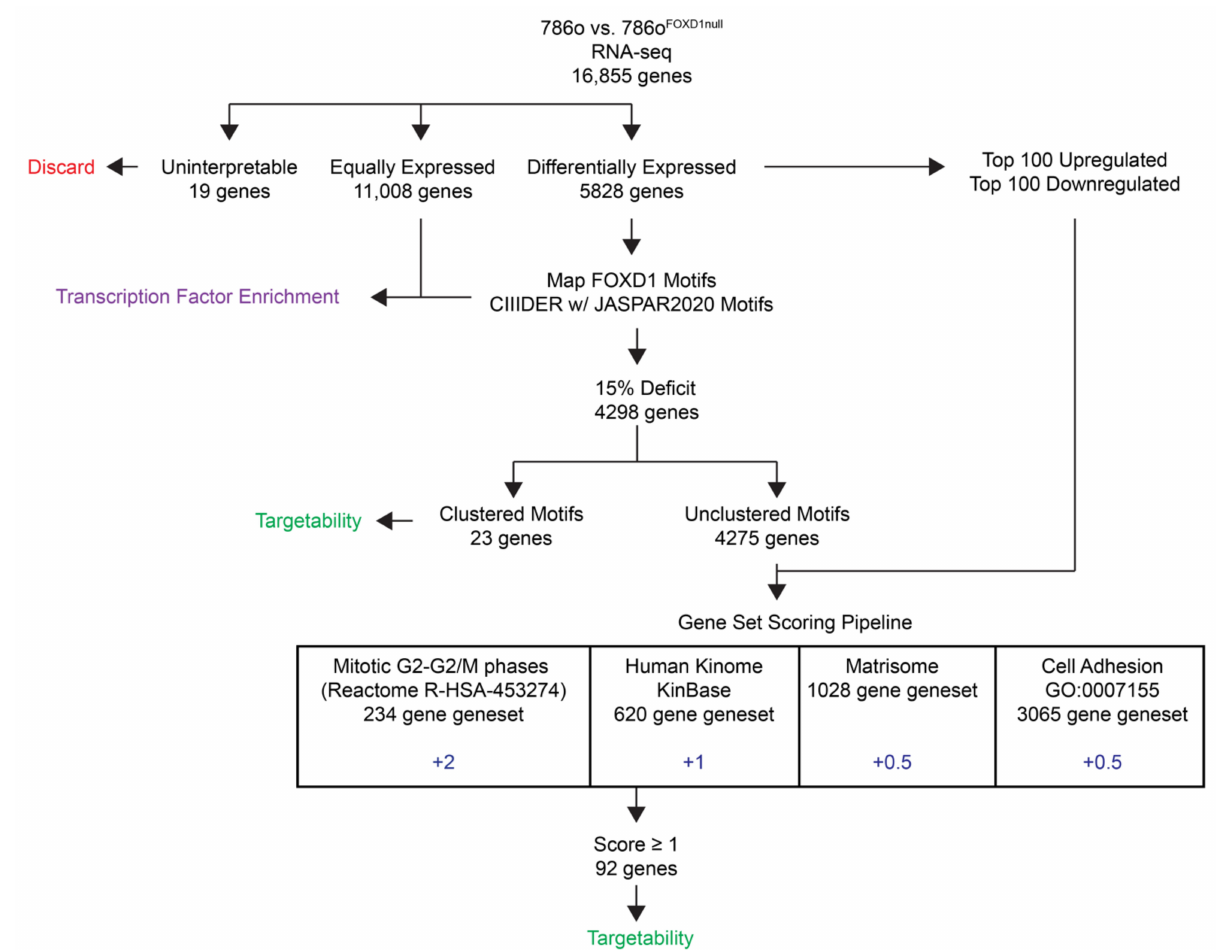
Figure 1. RNA-sequencing analysis and candidate